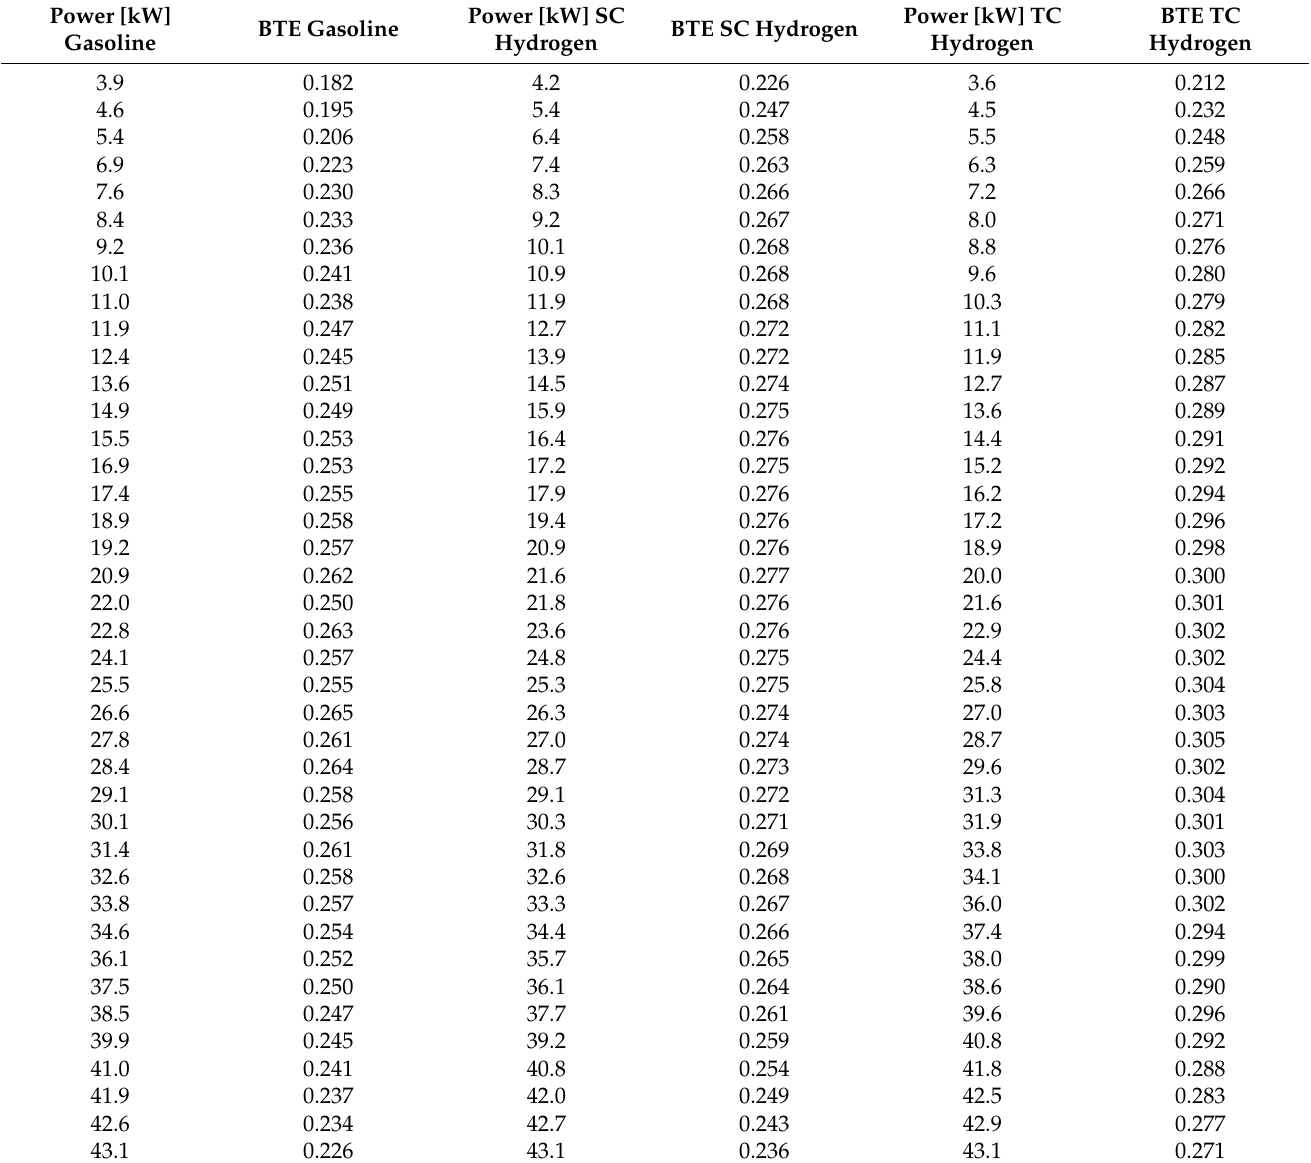
Table 3. The engine power and BTE of points lying on BEPs.